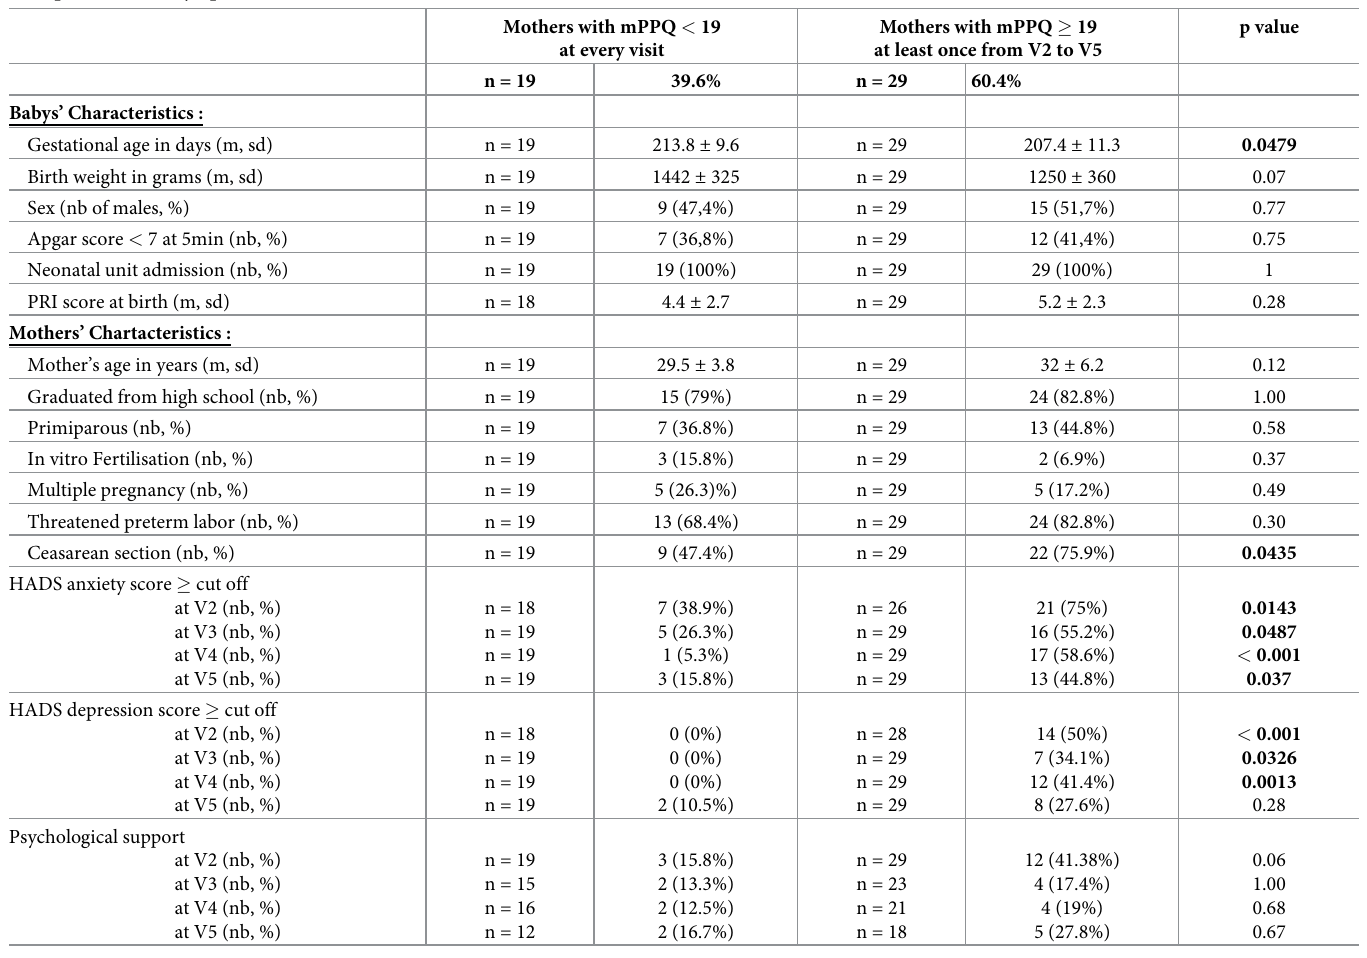
Table 5. Comparisons of socio-demographic and clinical characteristics between mothers with no significant posttraumatic symptoms and mothers with any signif- icant posttraumatic symptoms from V2 to V5.